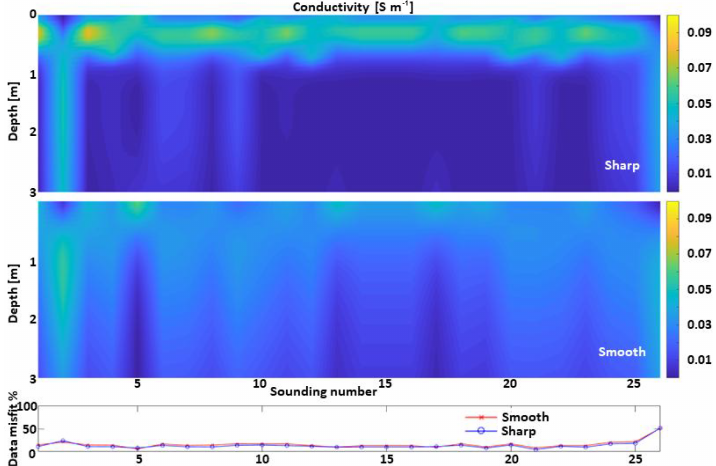
Figure 2. Examples of sharp and smooth inversions applied to the dataset 100-6dS. The results are shown together with their corresponding data